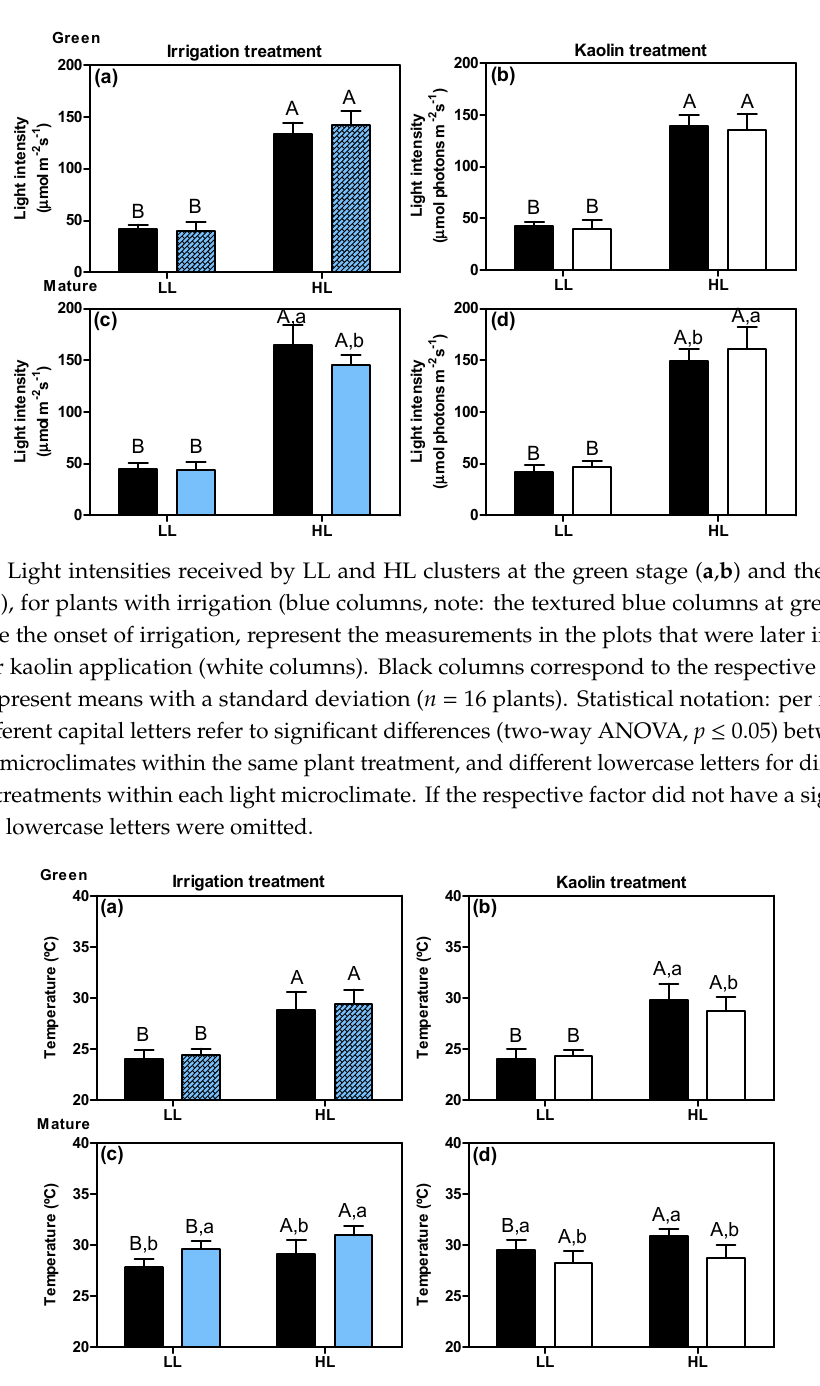
Figure 3. Temperatures of LL and HL clusters at the green stage ( a , b ) and the mature stage ( c , d ), for plants with irrigation (blue columns, note: the textured blue columns at the green stage i.e., before the onset of irrigation, represent the measurements in the plots that were later irrigated) and foliar kaolin application (white columns). Black columns correspond to the respective controls. Values represent means with standard deviation ( n = 16 plants). Statistical notation: per ripening stage, different capital letters refer to significant differences (two-way ANOVA, p ≤ 0.05) between the two light microclimates within the same plant treatment, and different lowercase letters for differences between treatments within each light microclimate. If the respective factor did not have a significant effect, the lowercase letters were omitted.